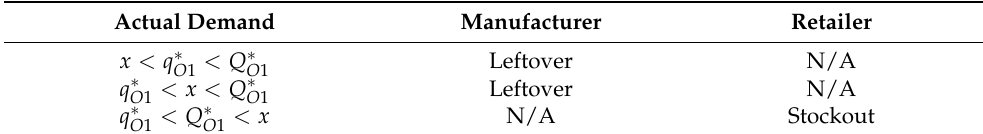
(cid:0) (cid:1) c 0 , c e , q ∗ , Q ∗ O 1 O 1